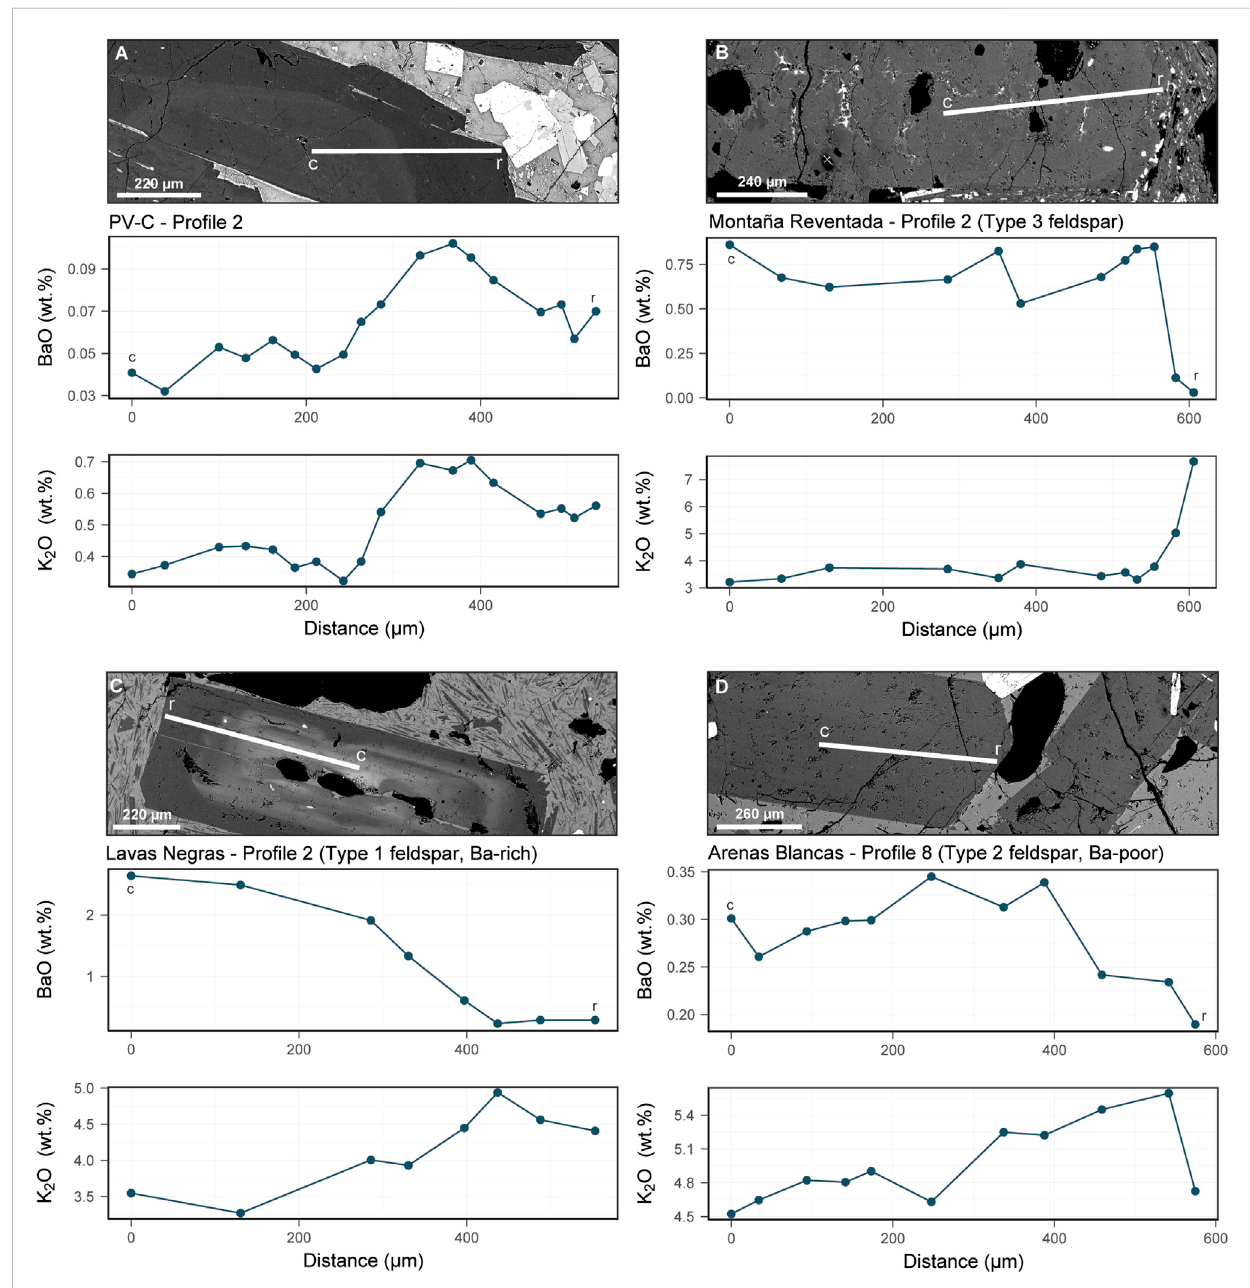
FIGURE 9 Zoning pro fi les showing compositional variations of BaO and K 2 O (wt%) within representative feldspar phenocrysts in (A) PV-C; (B) Montaña Reventada (Type 1 feldspar); (C) Lavas Negras (Type 1 feldspar, with Ba-rich cores); (D) Arenas Blancas (Type 2 feldspar, with Ba-poor cores). The pro fi le position is marked with a white line in accompanying back-scattered electron